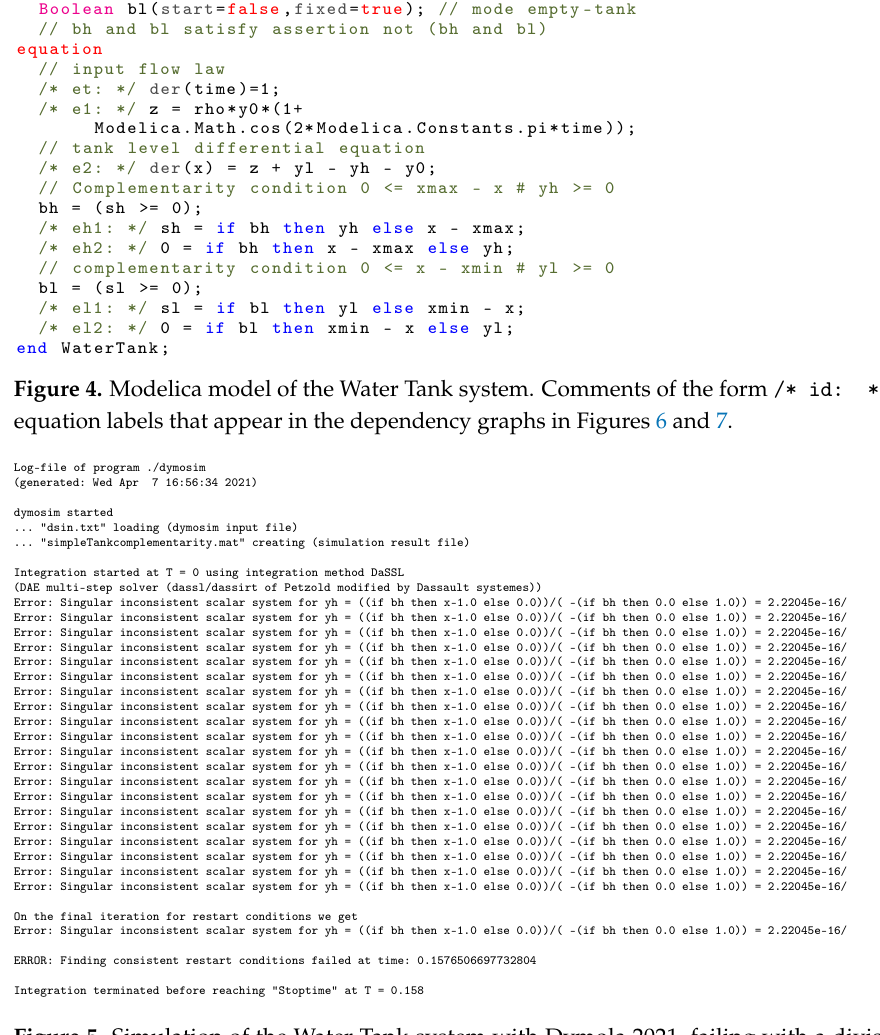
Figure 5. Simulation of the Water Tank system with Dymola 2021, failing with a division by zero